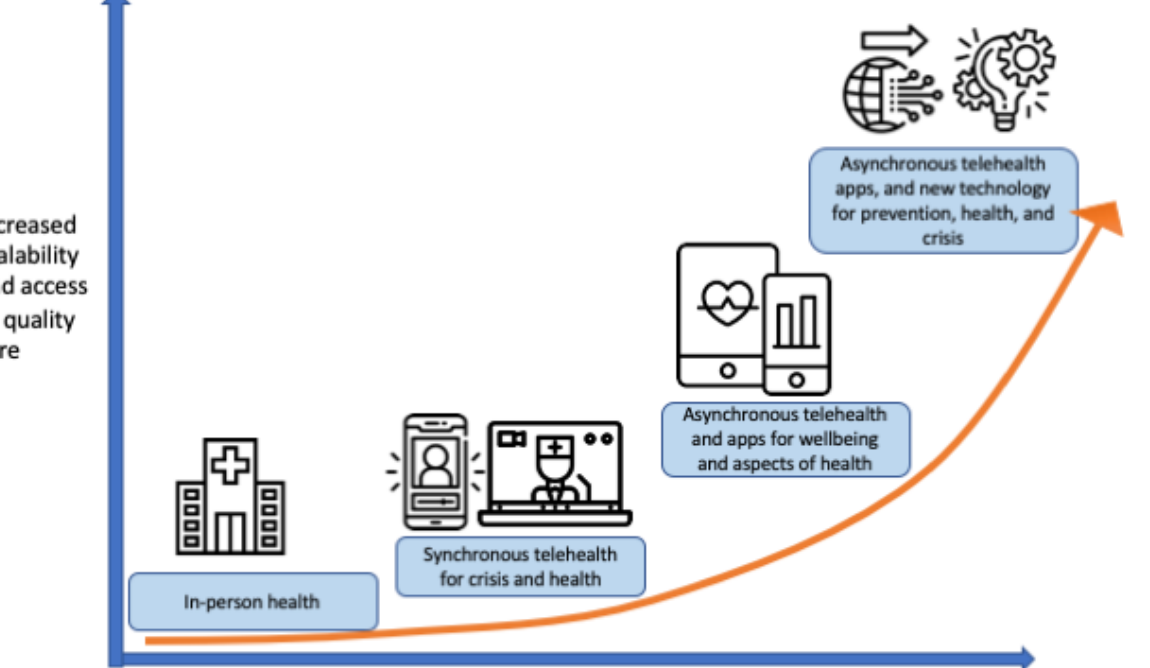
Figure 1. Bending the curve further on access and quality of care will require increased efforts around safety, evidence, engagement, outcomes, and implementation. However, these increased efforts will yield greater returns at each step. The COVID-19 crisis has (at least temporarily) removed implementation barriers to synchronous telehealth through regulatory changes, and the evidence, safety, and engagement were already in place